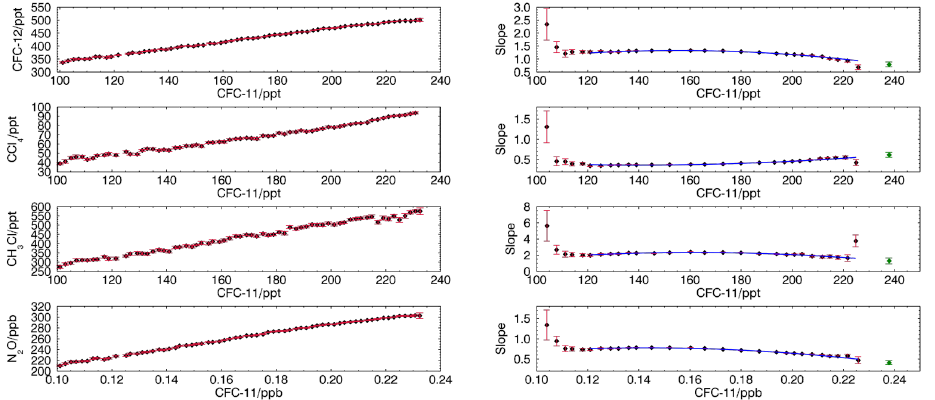
Figure B13 Correlations between the volume mixing ratios of CFC-12, CCl 4 , CH 3 Cl and N 2 O and CFC-11 for the data from the southern hemisphere during the stratospheric summer of 2008. Left panels: The mean correlation profile. Each point represents the mean of the VMR in a window of 2 ppt of CFC-11. The error on these points is the standard deviation of the data within each 2 ppt window. Right panels: The local slope of data in an 80 ppt of CFC-11 window. The error on the points is the fitting error of this fit. The blue line is a second degree polynomial fit to the local slopes. The green point is the extrapolated slope at the tropopause.